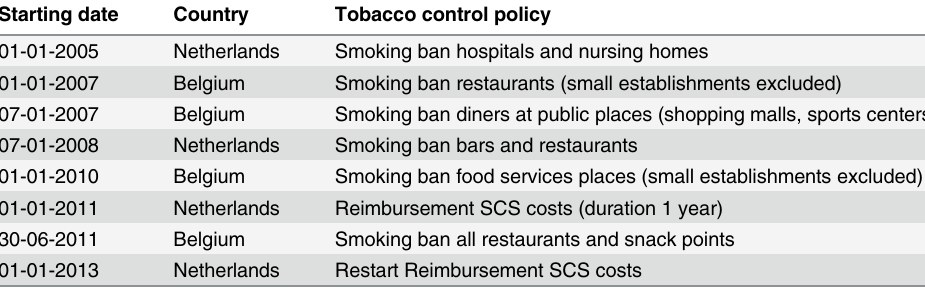
Table 1. Tobacco control policies implemented in the Netherlands and Belgium in the period 2004 –